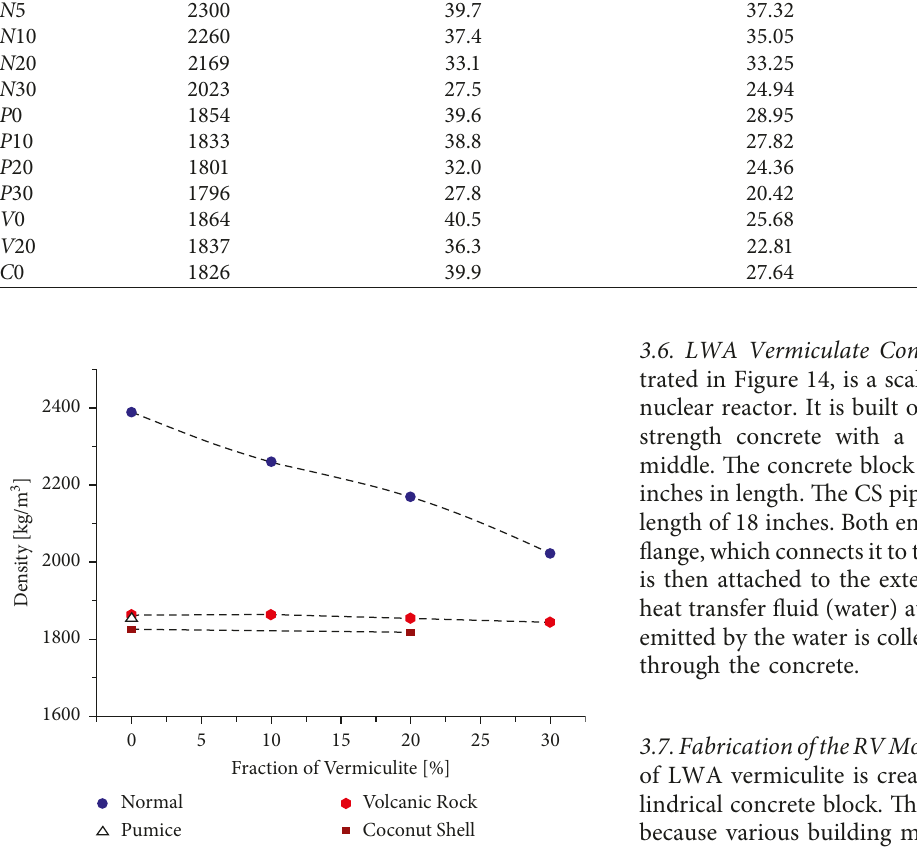
Figure 11: Density of specimens with a fraction of vermiculite.